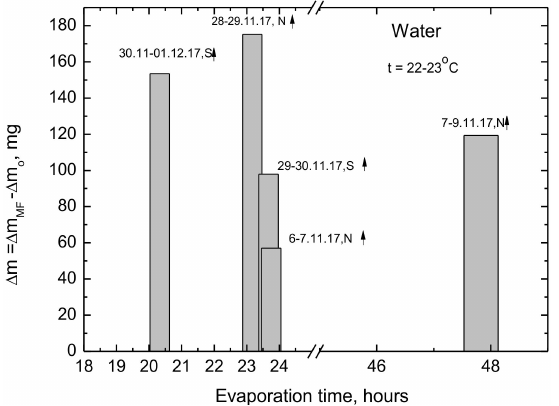
Figure 6. Differences in the evaporated amounts of water from the long-term MF treated and untreated